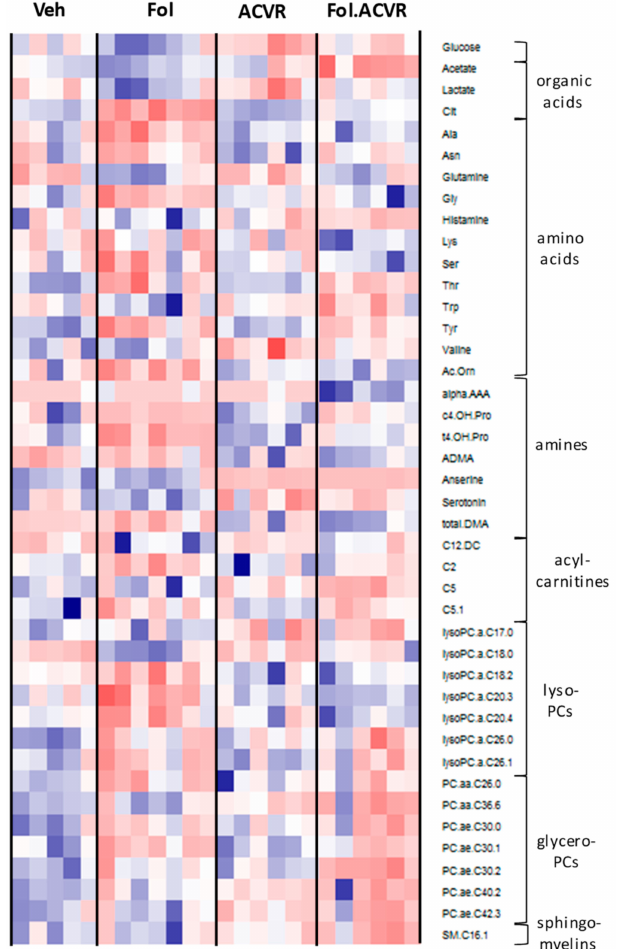
Figure 6. Heatmap of metabolites from muscle tissue extract that demonstrate at least one significant intergroup di ff erence as evaluated by one-way ANOVA with Tukey’s multiple testing correction and p -value less than 0.05. A total of 41 metabolites are shown as z-scores in the